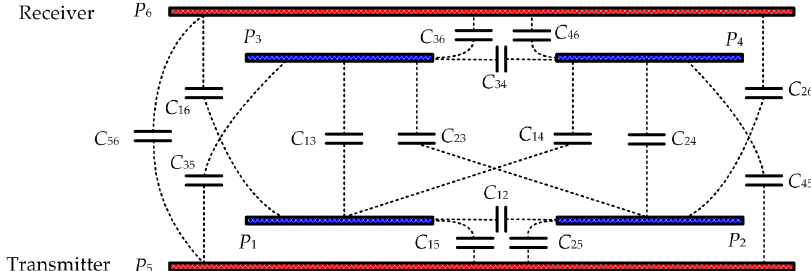
Figure 25. Structure of a six-plate capacitive coupler.